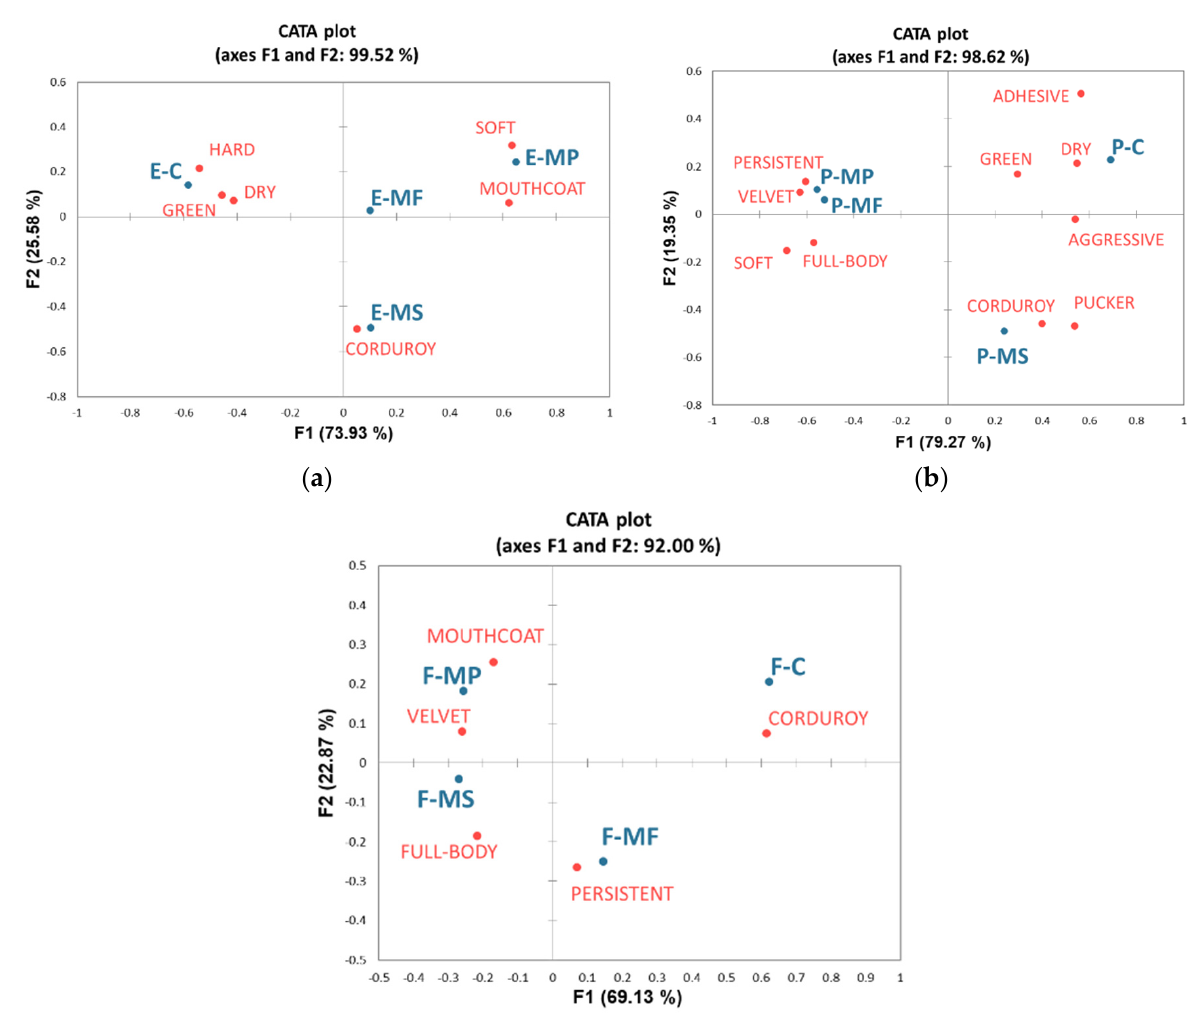
Figure 2. The mouthfeel profile of Sangiovese wines after six months of ageing with mannoproteins by the CATA analysis. The significant terms ( p < 0.01) were plotted for each wine typology: ( a ) extended maceration (E), ( b ) marc-pressed (P), and ( c ) free-run (F) wines. C represents the control wine; MF, MP, and MS are the mannoprotein treatments at 20 g/hL.